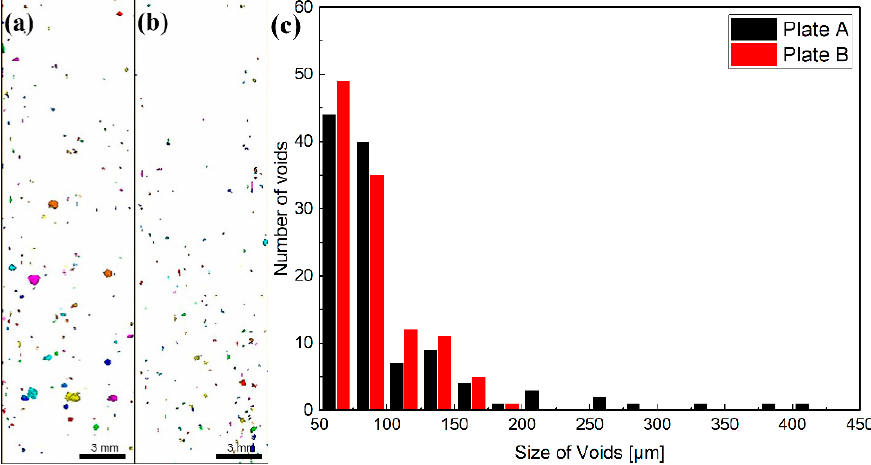
Figure 7. Ultrasonic testing results of plates: ( a ) Plate A; ( b ) Plate B; ( c ) size distribution of voids in plates.